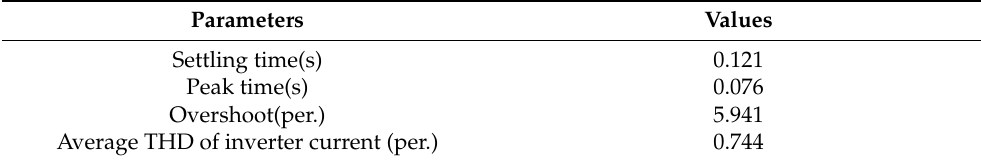
Figure 10. Synchronization of inverter voltage and grid voltage with fuzzy-PI controller. The AC output inverter, grid, and low load power for low-load fuzzy-PI controller are shown in Figure 11. The PV power is feeding load power and the remaining power is injected into the load. The result of the calculation of the overshoot = 5.94%, settling time(s) = 0.121, peak time(s) = 0.076, and average THD of inverter current = 0.744% are shown in Table 1. Table 1. The specifications of the fuzzy-PI controller are shown in Figure 11.